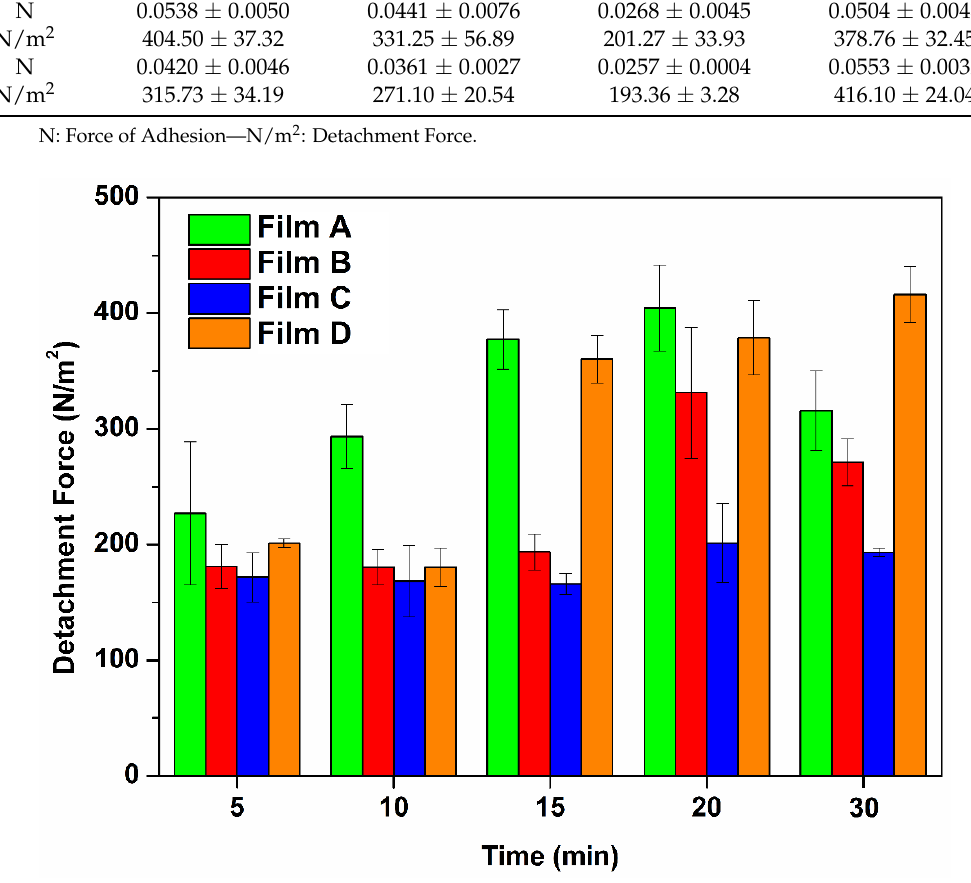
Figure 7. Detachment Force (N/m 2 ) as function of the contact preload time (min) with the buccal mucosa when evaluating Film A (green), Film B (red), Film C (blue), Film D (orange). Values are presented as means ± SE (n = 3).